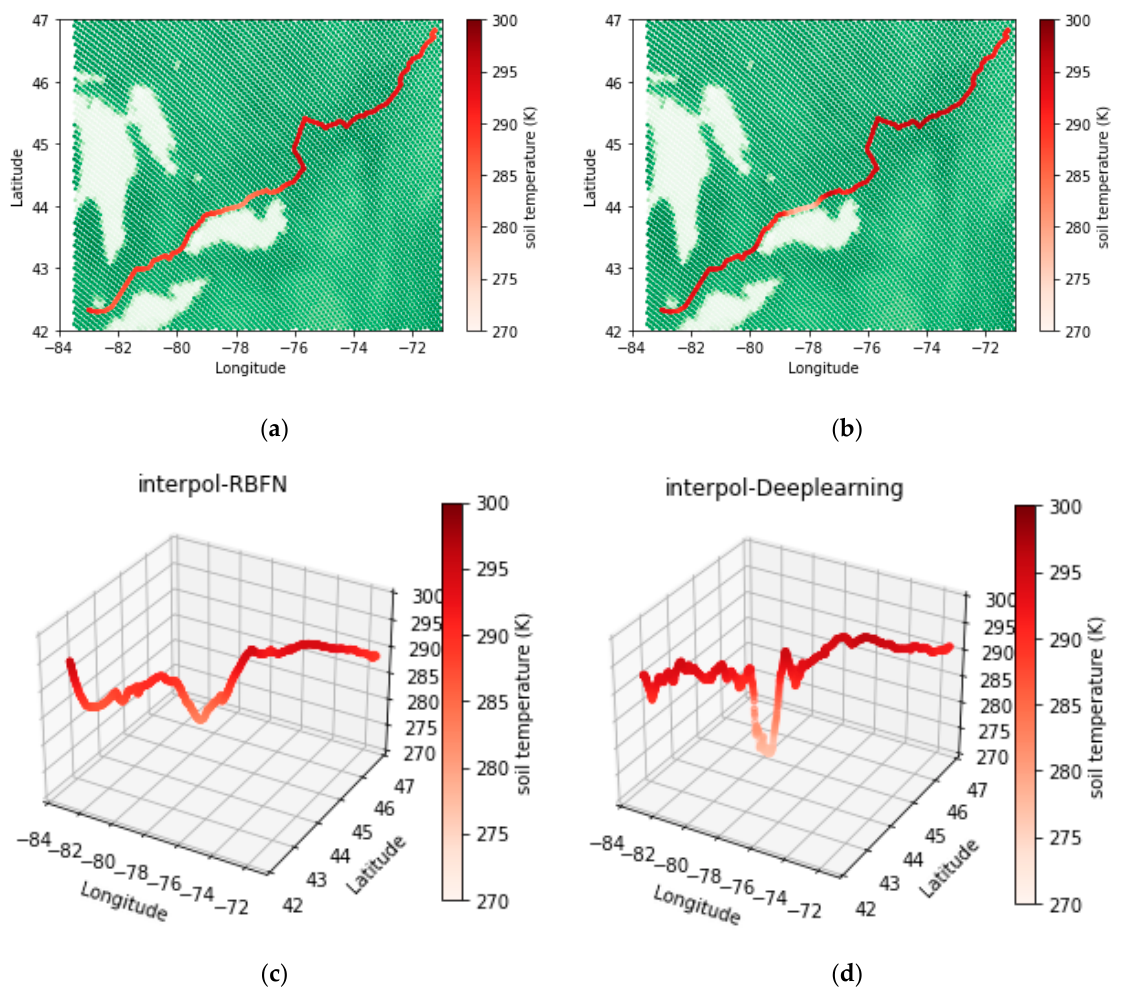
Figure 8. Interpolation soil temperature results along the railroad by ( a ) RBFN ( b ) Deep learning ( c ) 3D graph of RBFN ( d ) 3D graph of Deep learning.